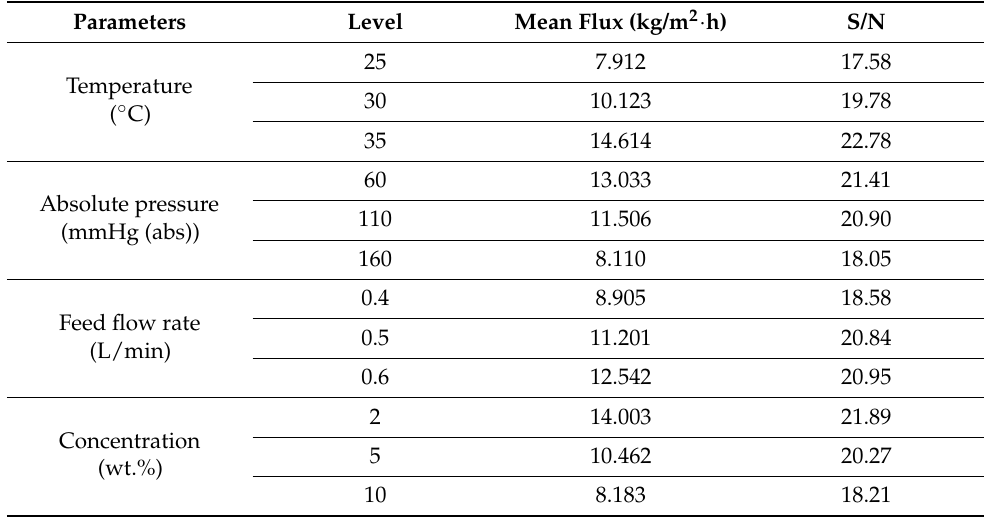
Table 6. Mean flux and S/N values at all levels of the operating variables obtained from the Taguchi method.